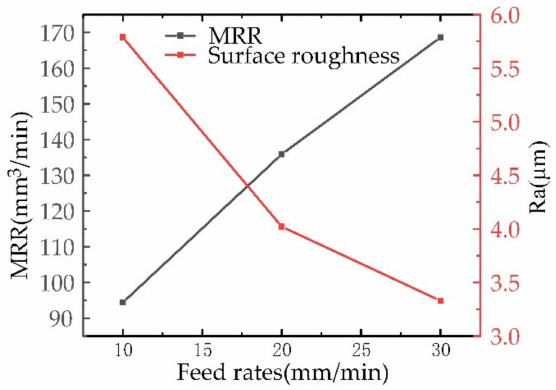
Figure 10. Material removal rate and surface roughness with the feed